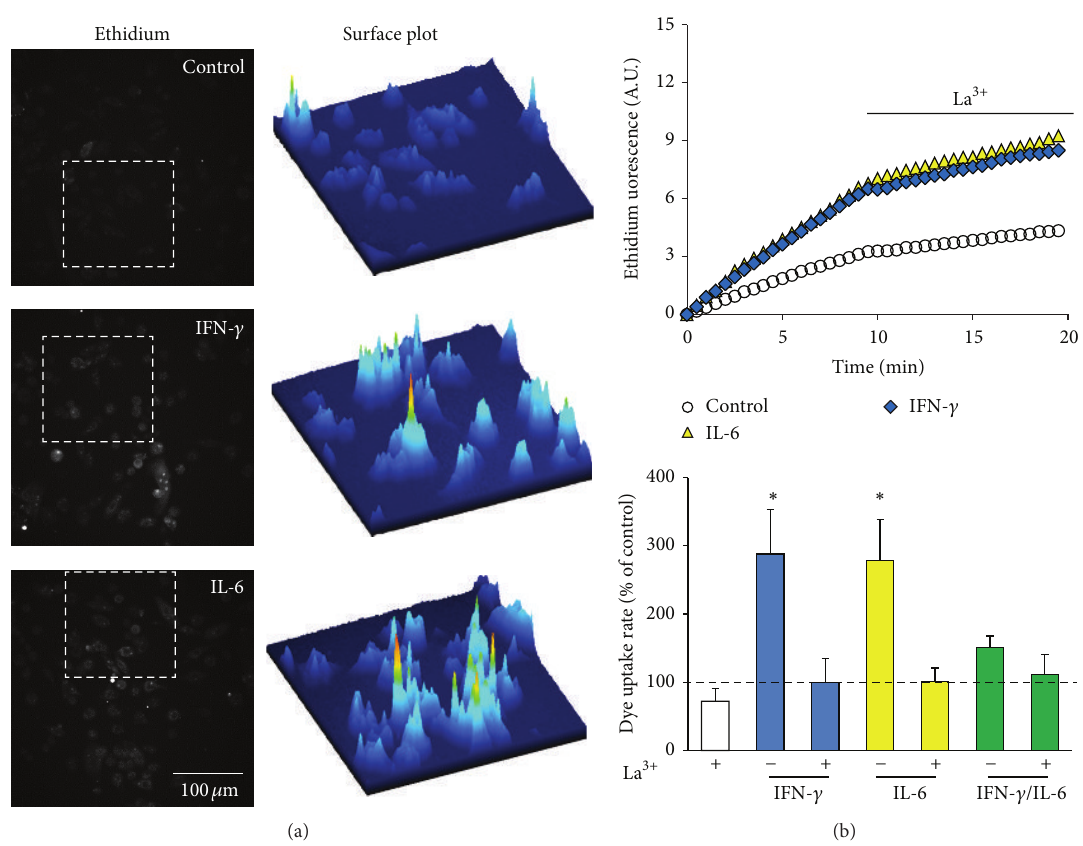
Figure 4: IFN- 𝛾 or IL-6 increases dye uptake in dendritic cells. Bone-marrow-derived dendritic cells (BMDCs) from balb/c mice were differentiated with 40 ng/mL GM-CSF and IL-4 for 7 days. At day 7, BMDCs were treated for 6h with IFN- 𝛾 (10ng/mL), IL-6 (10ng/mL), or both, and ethidium uptake was evaluated in time-lapse experiments (Olympus BX 51W1I). (a) Left: fluorescence images of ethidium after 9 min of uptake. Scale bar: 50 𝜇 m. Right: ImageJ surface plot analysis of fluorescence intensity of the region indicated in the field (dotted square). (b) Top: time-lapse ethidium uptake under control conditions (white circles) or after 6h treatment with IL-6 (yellow triangles) or IFN- 𝛾 (blue diamonds). Each point corresponds to the mean of 30 cells. After 10 min of recording, La 3+ (200 𝜇 M) was added to the bath solution to block connexin hemichannels. Bottom: graph showing the basal dye uptake rate and the effect of La 3+ on BMDCs after treatment with IFN- 𝛾 (blue bars), IL-6 (yellow bars), or both (green bars). Each bar corresponds to the mean ± SE (% of control condition, dotted line) of 3 independent